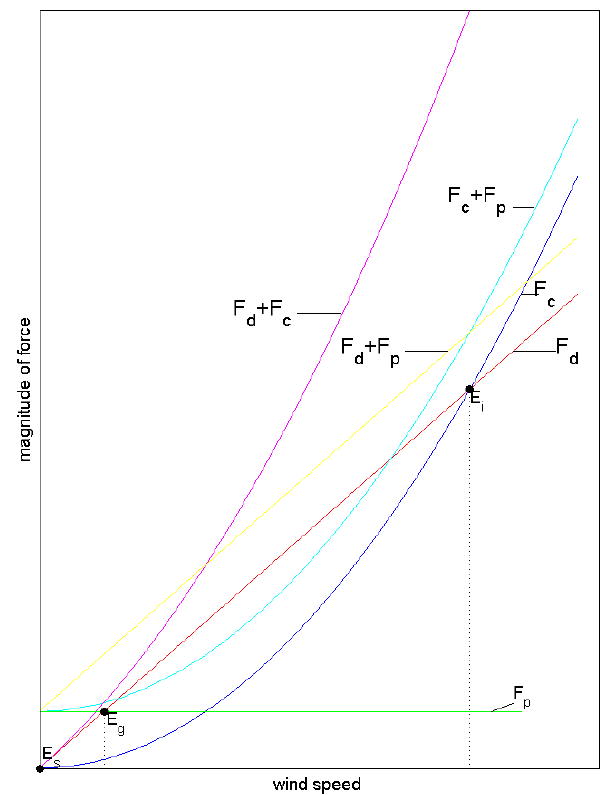
Figure 2. A wind–force relation diagram. The horizontal axis repre- sents the wind speed and the vertical axis represents the magnitude of forces. Curve F d represents the Coriolis force (deflection force of earth rotation), curve F c the centrifugal force, curve F p the pres- sure gradient forces, curve F c + F p the sum of the centrifugal and the pressure gradient force, curve F d + F p the sum of the Coriolis and the pressure gradient force and curve F d + F c the sum of the Coriolis and the centrifugal force. The curves are calculated from the force magnitude function of wind speed. Point E s represents the state of static wind, E g the geostrophic wind and E i the inertial